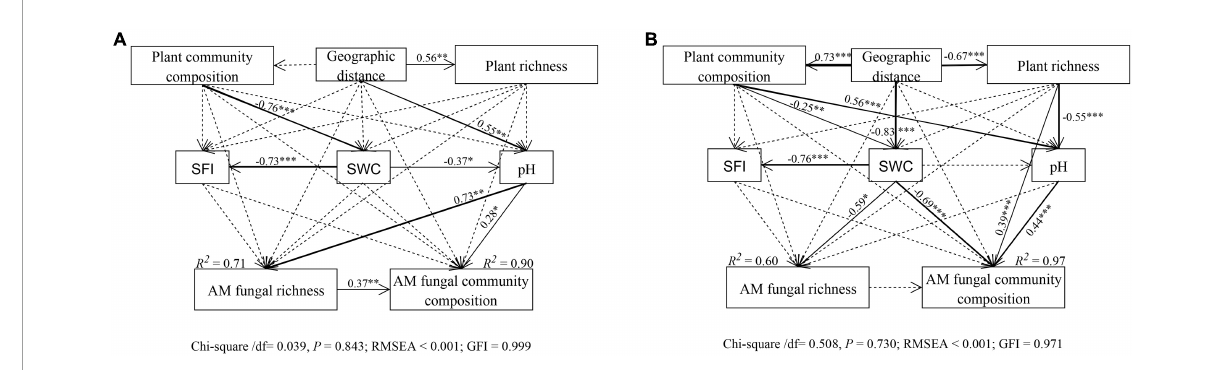
FIGURE8 Structural equation model (SEM) showing causal relationships among geographic distances, plant variables, soil variables, AM fungal richness and community composition in the near (A) and far (B) bank soils. Solid and dashed lines indicate significant and non-significant pathways, respectively. The width of the solid line indicates the strength of the causal effect. The R 2 value represents the proportion of variance explained for each variable.